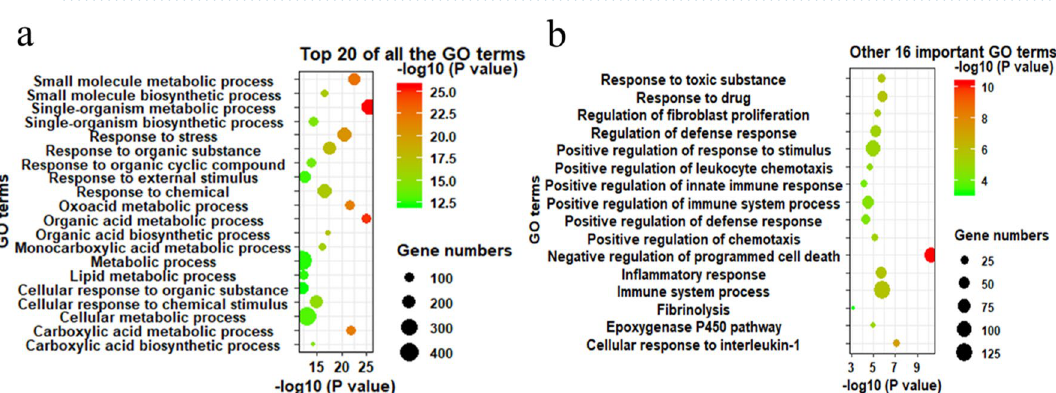
Figure 5. Visualization of the functional annotation of differentially expressed protein-coding transcripts. ( a ) The top 20 significantly enriched GO biological process terms. ( b ) The other 16 important enriched GO biological process color). Each co-expression module represented a group of transcripts with similar expression profiles across all the samples. The top 50 hub nodes were extracted from each module based on analysis of the co-expression network between the lncRNAs and protein-coding DETs of each module. We constructed a network of each module using Cytoscape software (Fig. 6b–d). The network results revealed that the differentially expressed lncRNA transcripts